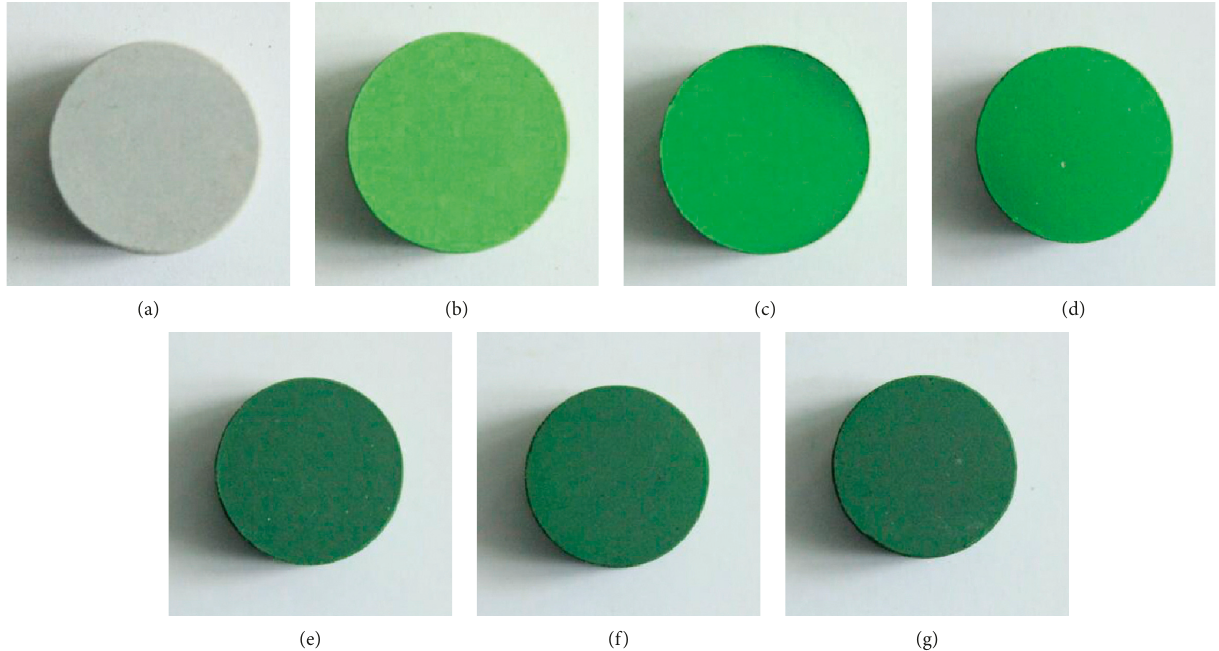
° C 2 O 3 +011) sintered at different temperatures. (a) 25